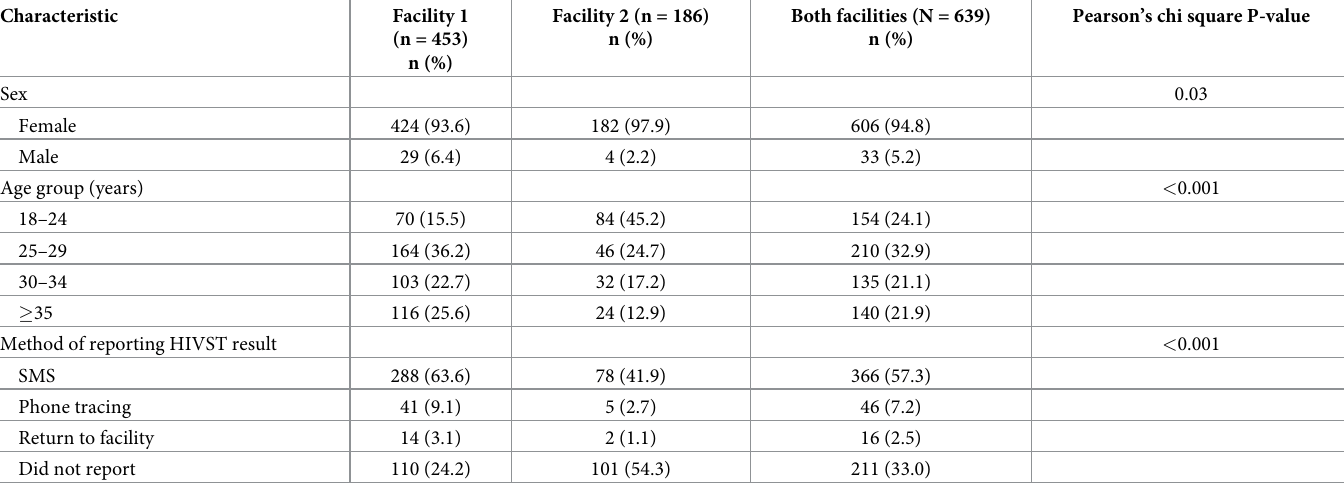
Table 2. Participant characteristics (N =